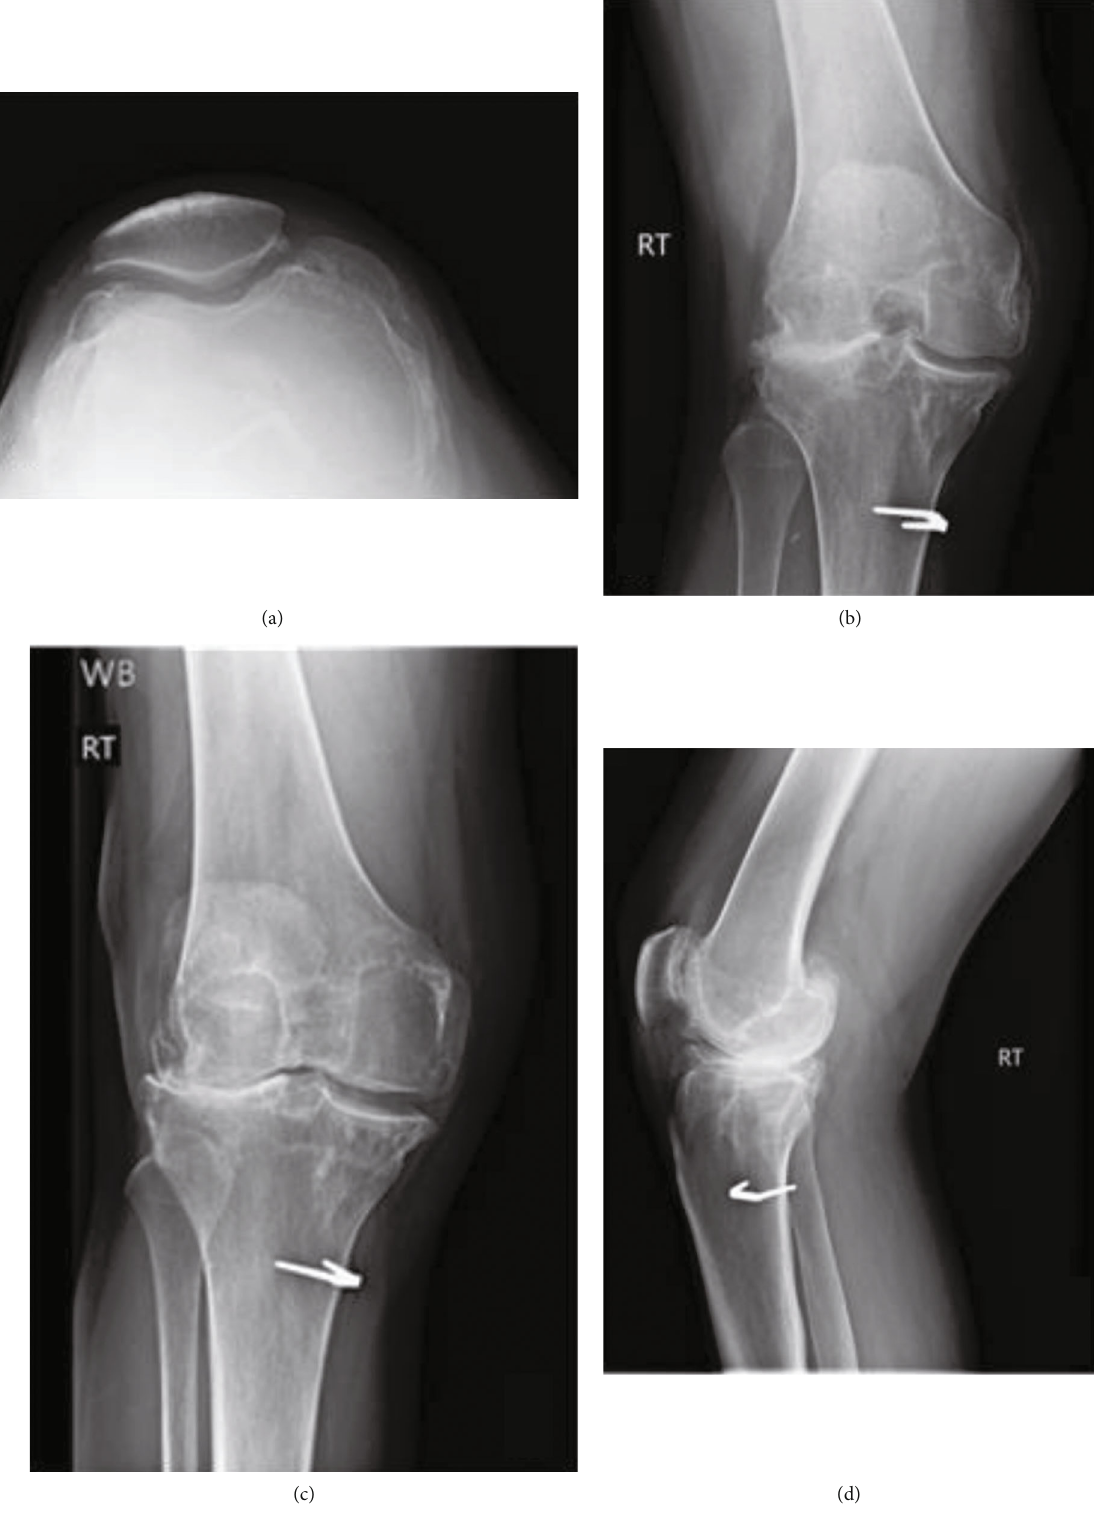
Figure 12: Preoperative X-ray of Case 4 showing severe osteoarthritic changes including (a) sunrise view, (b) notch view, (c) AP view, and (d) lateral